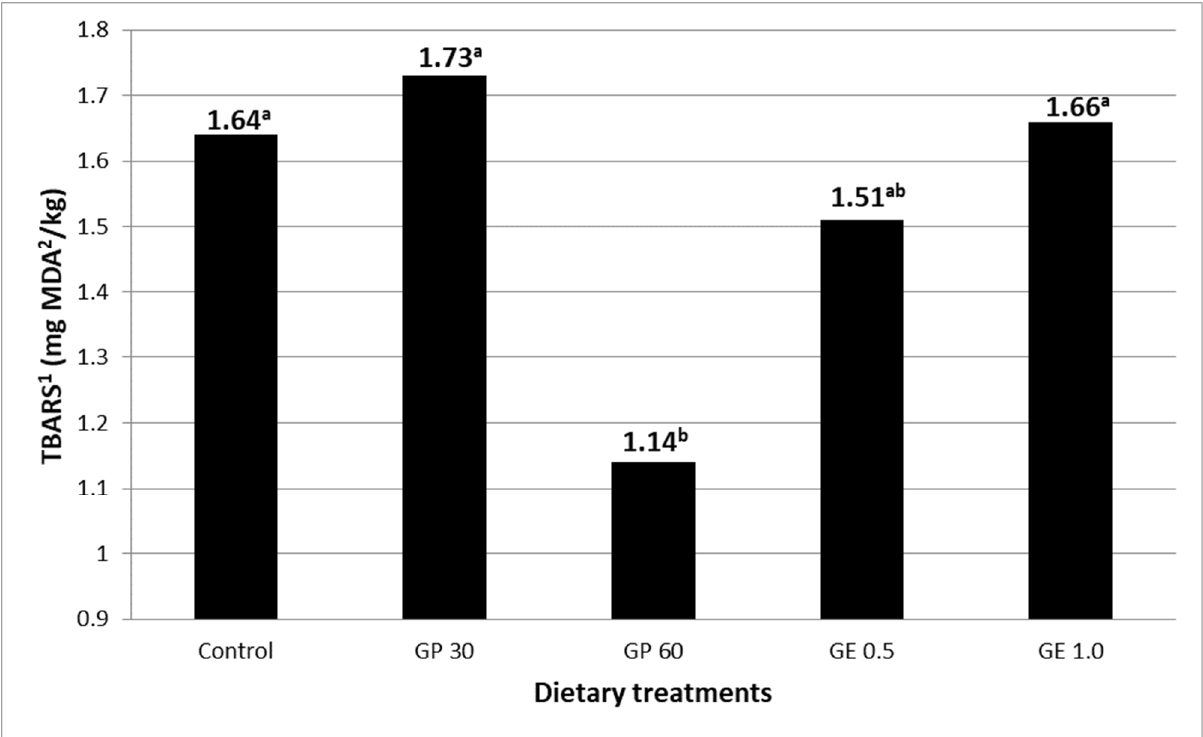
Figure 2. Yolk lipid oxidation (SEM 3 = 0.149, * ) measured in four-month-stored eggs of laying hens fed diets containing grape pomace (GP) or grape extract (GE) at different concentrations. Different letters (a, b) indicate significant differences ( p < 0.05). 1 TBARS: thiobarbituric acid reactive substances. 2 MDA: malondialdehyde. 3 SEM, standard error of means; each value represents the mean of nine samples per dietary treatment (three samples per replicate); each sample resulted from the pool of two yolks. * p < 0.05.